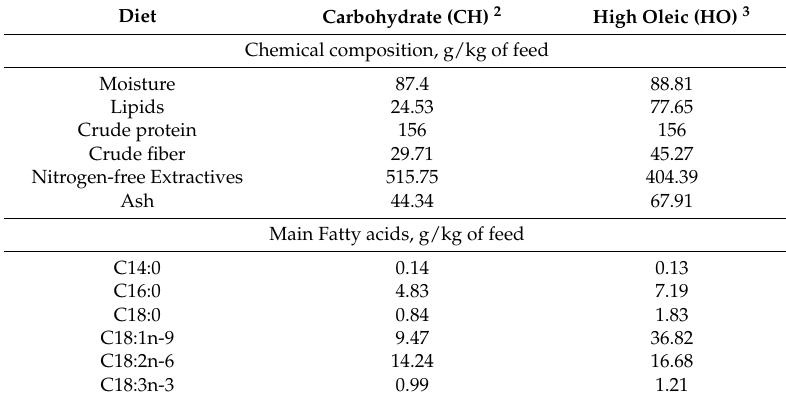
Table 5. Calculated analysis 1 and fatty acid composition of the experimental diets (g/kg, as-fed basis).